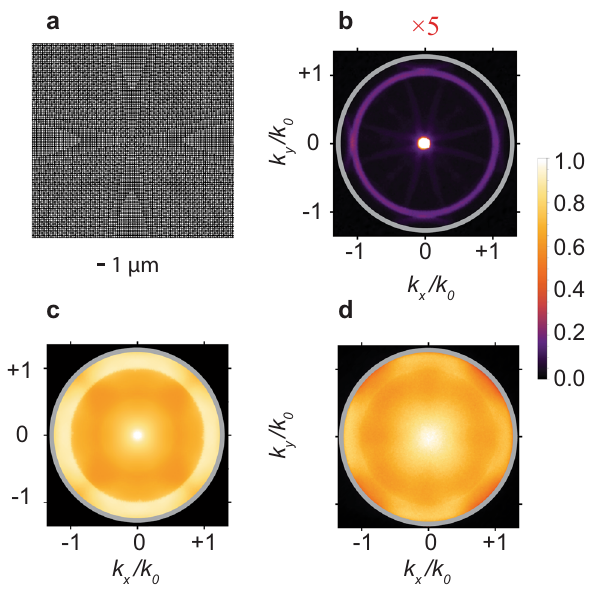
Fig. 2 Luminescent meta-axicons for collimating ordinarily trapped spontaneous emission. a SEM image of the meta-axicon. b Back-focal- plane (BFP) image of the meta-axicon illuminated with a normally incident light at a wavelength of 560 nm. The bright spot at the center is the uncoupled incident light. The image is saturated by a factor of 5 to make the ring at k ¼ 1 : 06 k 0 , corresponding to the converted light, easily visible. c Theoretically derived, unpolarized emission of the light-emitting meta- axicon. The incident light used for this calculation is the calculated BFP of the InGaN/GaN thin fi lm. d Measured unpolarized emission pattern of the light-emitting meta-axicon. The gray ring corresponds to NA =